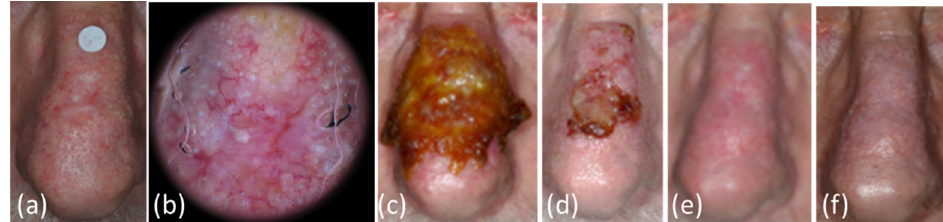
Figure 1. Patient/tumor 14 (Table S1, Supplementary Materials). ( a , b ) Clinical and dermoscopic picture of the relapsed basal cell carcinoma one year after surgery in a 67 year old patient. The tumor diameter was measured at 15 mm with the absence of clear borders. Solar damage of the surrounding skin of the nose was also evident. ( c ) After 2 weeks of daily imiquimod treatment at the day of cryosurgery treatment. There was extended skin inflammation due to the application of imiquimod on the whole of the nose. The cryosurgery was spatially confined on the initial tumor area and a narrow skin rim around it. ( d ) At the last day of imiquimod application (day 35), end of treatment. The intense inflammatory response had subsided. ( e ) At the one-month post-treatment follow-up appointment. ( f ) Thirty-six months after the end of treatment: no relapse and an excellent cosmetic outcome were recorded.